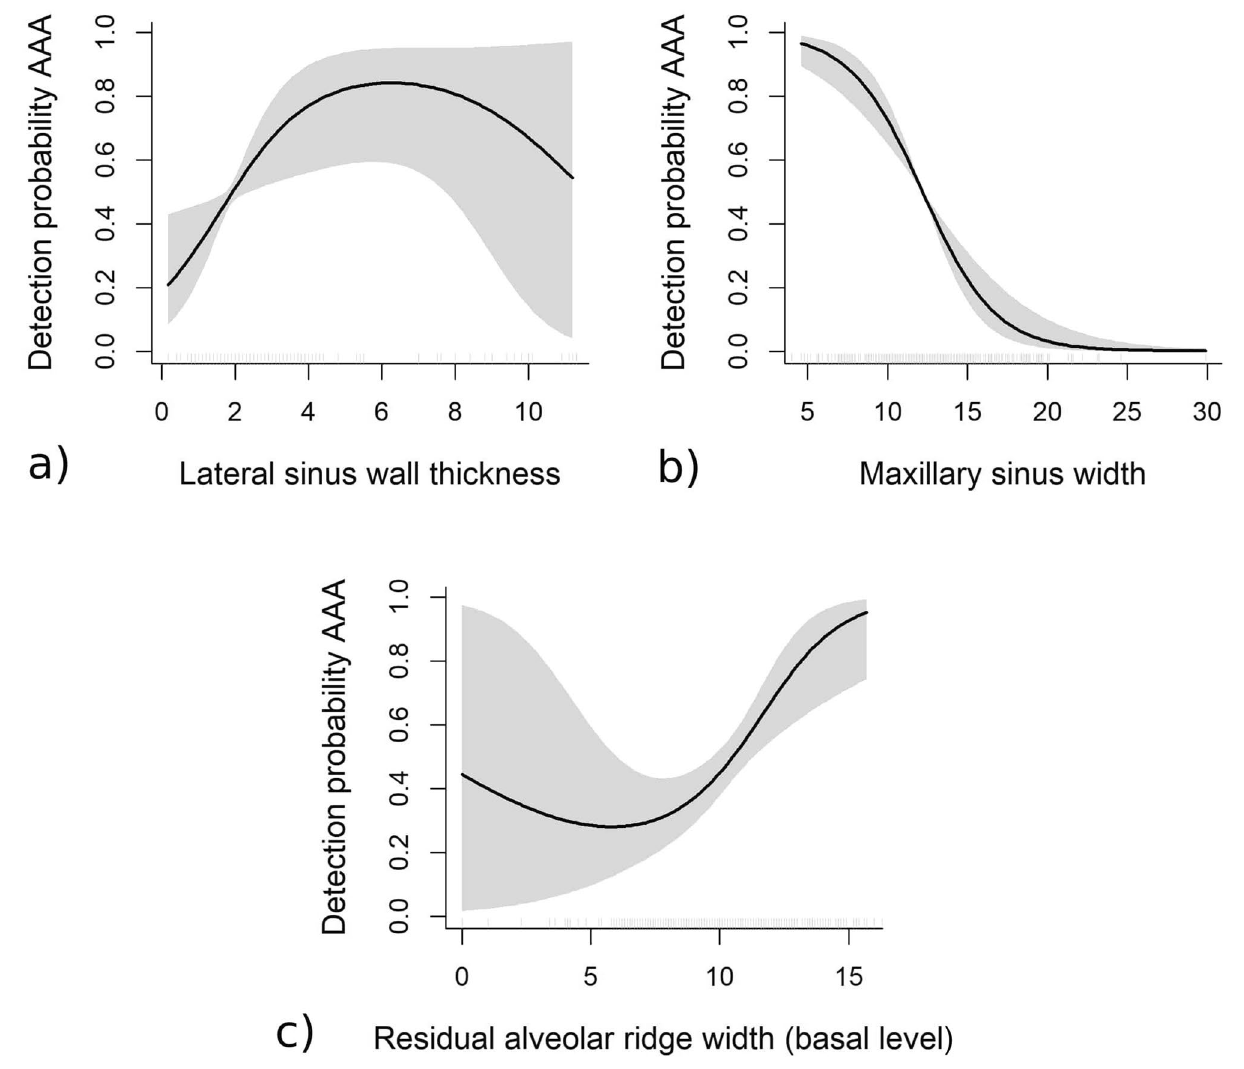
Figure 1. Detection probability for female patients (shaded grey area representing 95% point-wise confidence band). ( a ) Effect of lateral sinus wall thickness on detection probability AAA; ( b ) Effect of maxillary sinus width on detection probability AAA; ( c ) Effect of residual alveolar ridge on detection probability